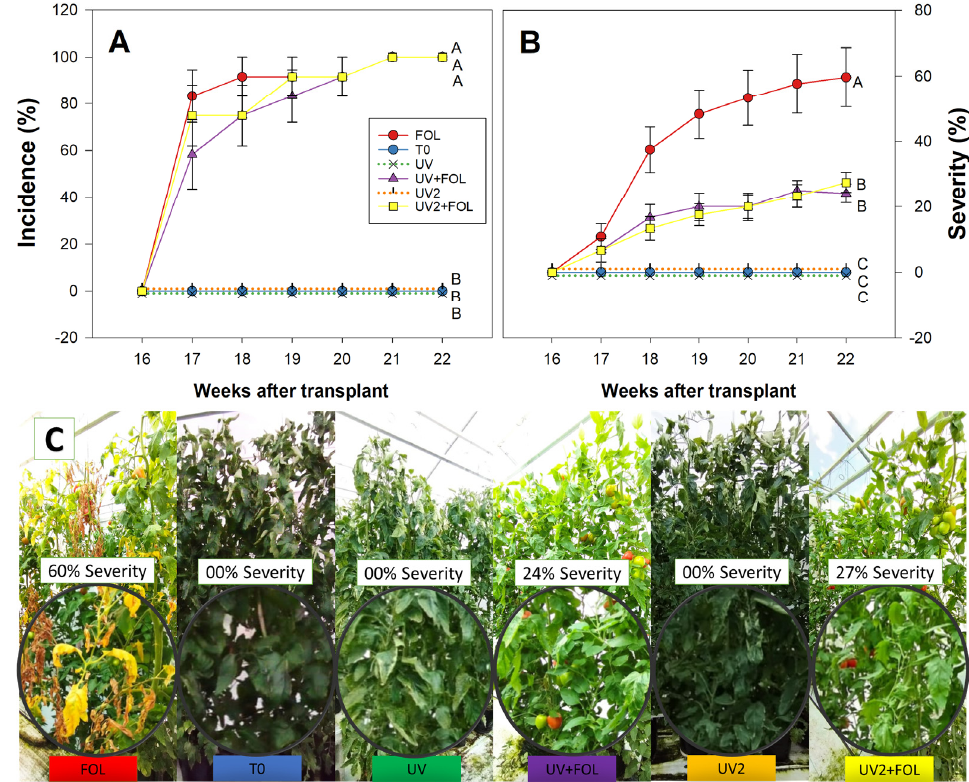
Figure 2. Impact of UV-A radiation on the ( A ) incidence and ( B ) severity of Fol in tomato plants, and ( C ) state of development of the plants at 22 weeks after transplanting. Different letters between treatments indicate significant differences according to Hotelling’s test ( p < 0.05). n = 12 ± standard error. T0, negative control (tomato plants without UV-A radiation and without Fol inoculation); FOL, positive control (tomato plants only inoculated with Fol); UV, tomato plants supplemented with UV-A radiation via one LED lamp; UV + FOL, tomato plants supplemented with UV-A radia- tion via one LED lamp and inoculated with Fol; UV2, tomato plants supplemented with UV-A ra- diation via one LED lamp above the plant canopy plus one fi xed lamp at the plants’ bo tt om; and UV2 + FOL, tomato plants inoculated with Fol and supplemented with UV-A radiation via one LED lamp above the plant canopy plus one fi xed lamp at the bo tt om of the plants.